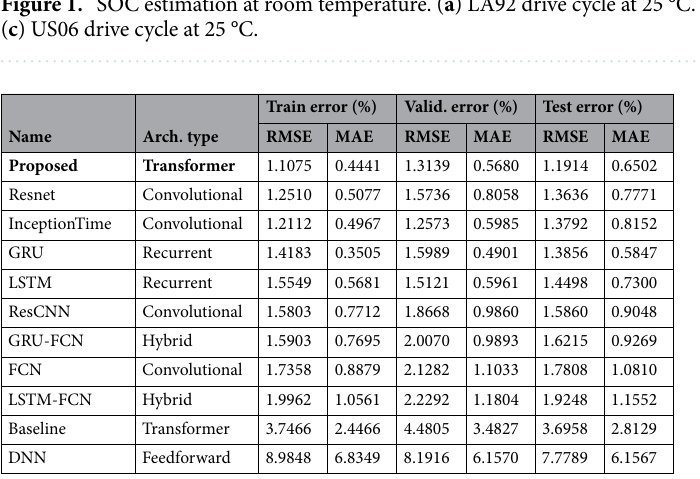
Table 2. Cross-comparison of the SOC estimation accuracy on the train, validation, and test dataset at varying ambient